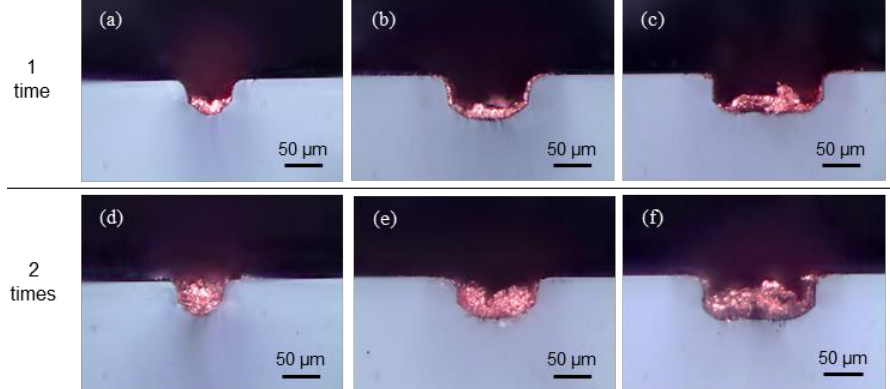
Figure 9. Optical images of embedded copper wires from a section view with a single laser scan and widths of ( a ) 50 µ m, ( b ) 100 µ m, and ( c ) 150 µ m and with multiple laser scans and widths of ( d ) 50 µ m, ( e ) 100 µ m, and ( f ) 150 µ m.